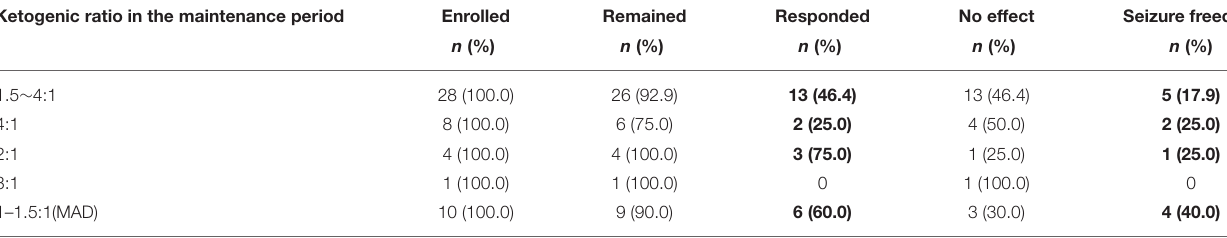
TABLE 5 | KD efficacy in groups of different ketogenic ratios in the maintenance period. Ketogenic ratio in the maintenance period